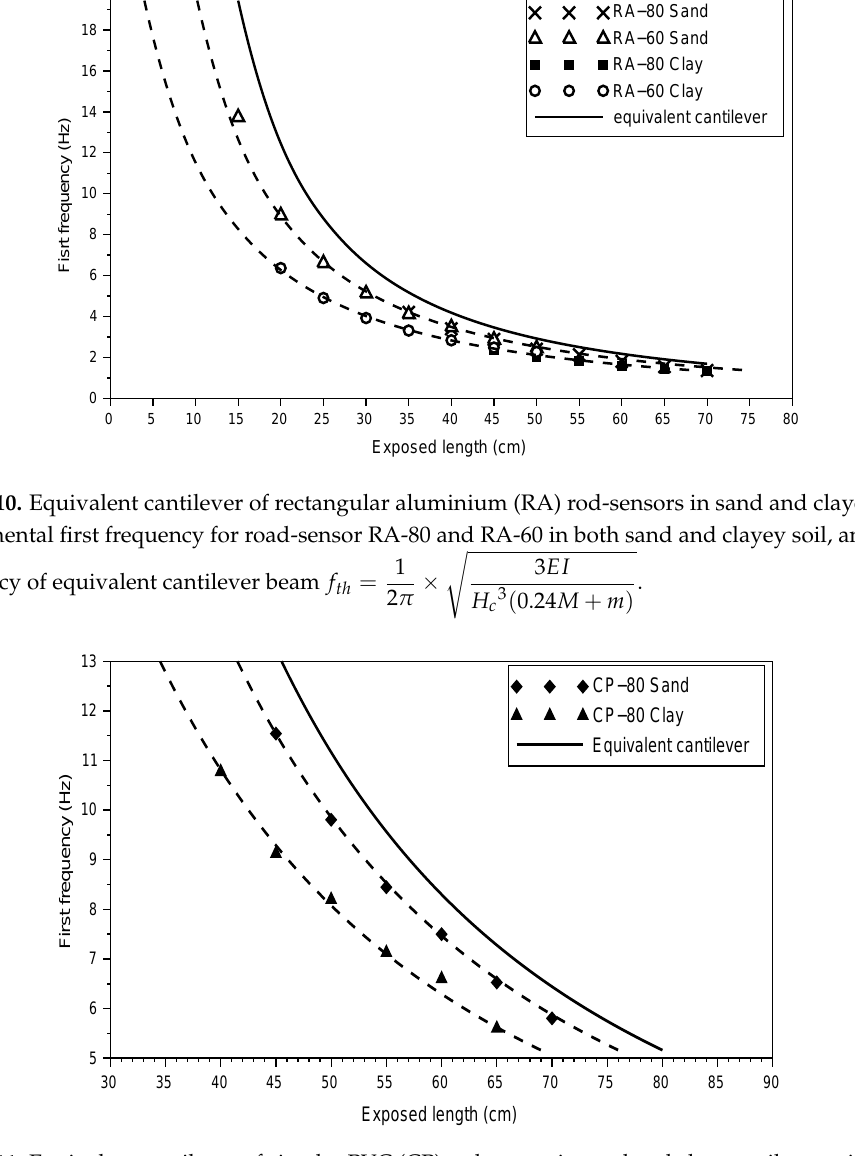
Figure 11. Equivalent cantilever of circular PVC (CP) rod-sensor in sand and clayey soil: experimental first frequency for road-sensor CP-80 and RA-60 in both sand and clayey soil, and first frequency of (cid:115) 1 3 EI × cantilever beam f th = 2 π H c 3 ( 0.24 M + m )